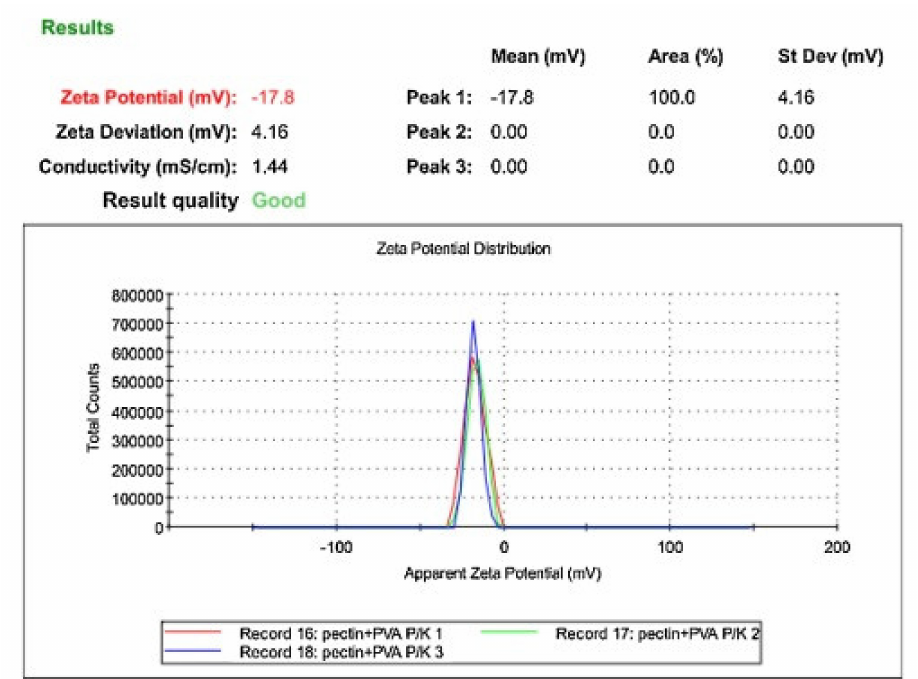
Figure 2. Draws the Zeta potential evaluation of Pectin/Polyvinyl alcohol polymer coating. The negative zeta potential value ( − 17.8 mV) indicating that the surface of the polymer is negatively charged owing to the ionization of the carboxyl groups of pectin. A zeta potential that is higher than 30 mV or lesser than − 30 mV is indicative of a stable